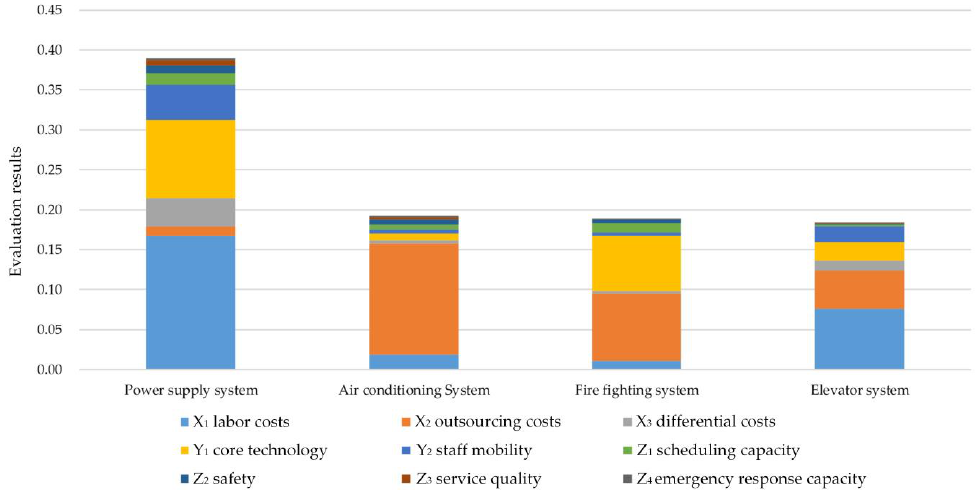
Figure 7. The weights of evaluation factors in the 3rd layer of the power supply, air conditioning, firefighting, and elevator systems.